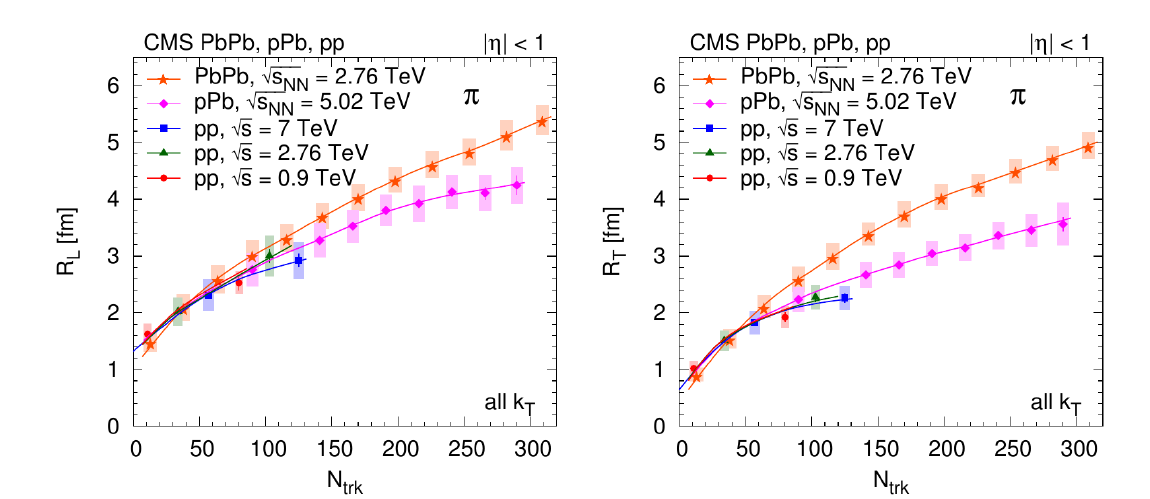
Figure 11. Geometry of the particle emission region measured in di ff erent collisions systems at di ff erent energies, see Ref. [14]. Shown are the parameters longitudinal size R L (left) and transverse size R T (right) as function of number of tracks, N trk . Figure 7. The ratio between proton-lead by lead-proton rates Figure 9. The average number of charged particles as function of of very forward jets measured in CASTOR as function of the central Z p T , see Ref. [12], in proton-proton collision of di ff erent observed jet energy, see Ref. [10]. centre-of-mass energies.